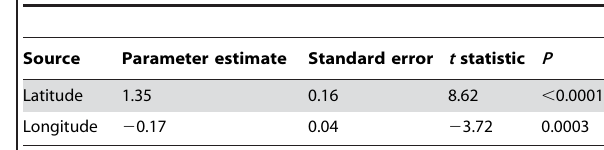
Table 1. Multiple regression analysis of the effects of latitude and longitude on flowering time.